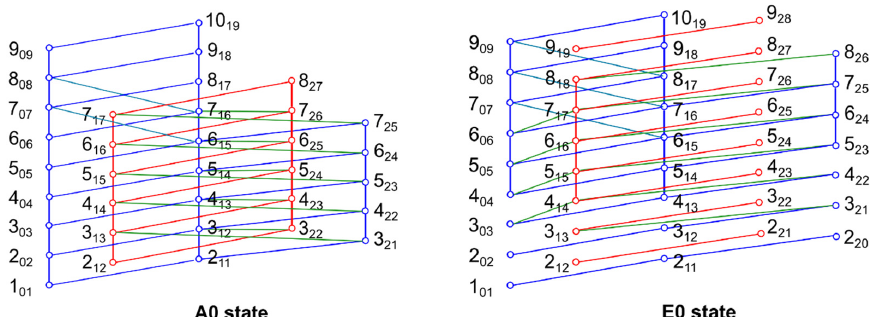
Figure 8. Schematic illustration of some rotational energy levels J K (open circles) of the A0 and E0 species of phenyl acetate measured with the Aachen FTMW spectrometer. Solid lines connecting the circles indicate transitions that are checked by combination difference loops, which sum to values in good agreement with the expected measurement uncertainty of 2 kHz. These transitions were used for an initial spfit fit whose spcat predictions have guided the assignments of further lines. Note that for the E0 states, some a -type transitions are weak or fall in resonance ranges of the spectrometer and could not be measured. Therefore, some loops are not closed.